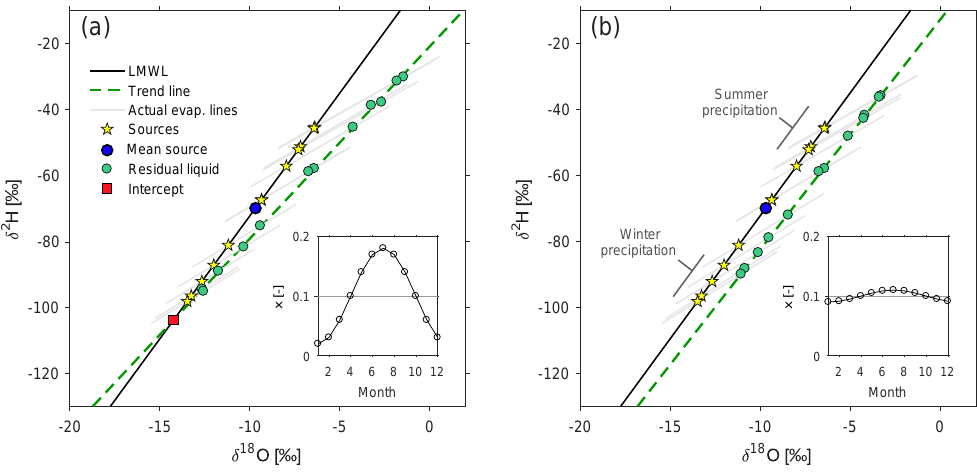
Figure 4. Effect of atmospheric seasonality on the isotopic composition of residual water from seasonally varying precipitation. The evapo- ratively fractionated residual water samples (green dots) cluster around a trend line (dashed line) which is much steeper than the individual evaporation lines (grey lines). The effects of strong and weak seasonality in evaporation rates (represented by x , the fraction of the initial volume that has evaporated) are shown in (a) and (b) , respectively. The insets show the assumed annual cycles in evaporated fractions x .